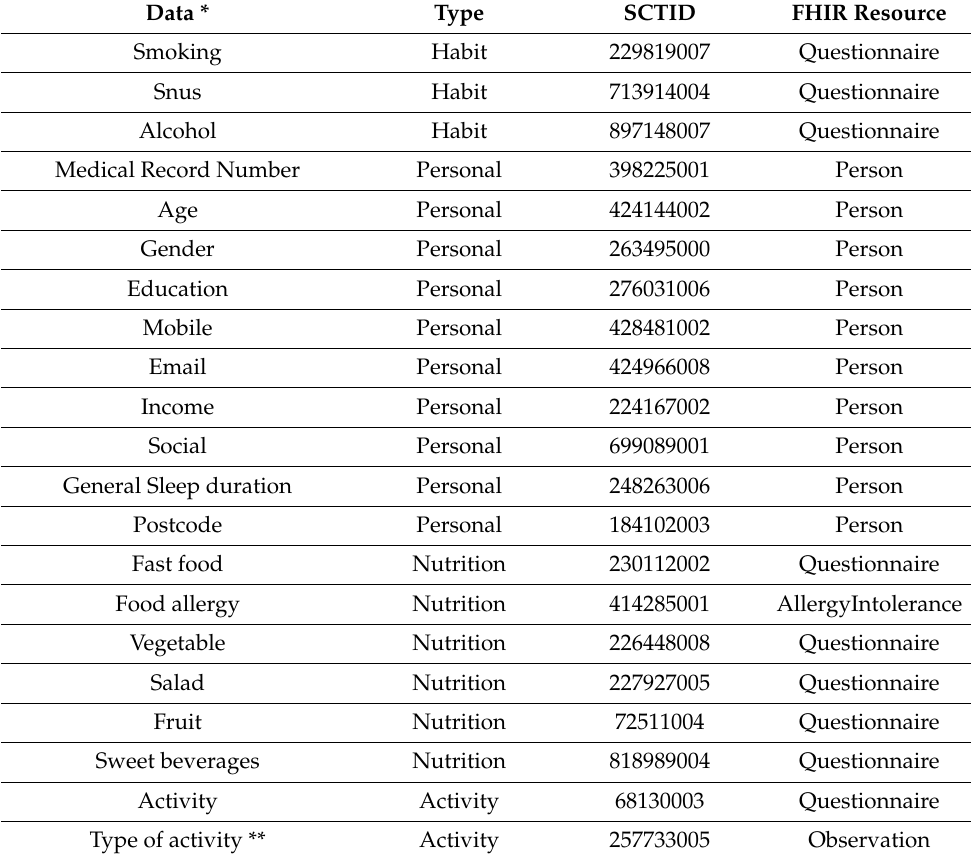
Table A2. Semantic interpretation of personal and person-generated health data with